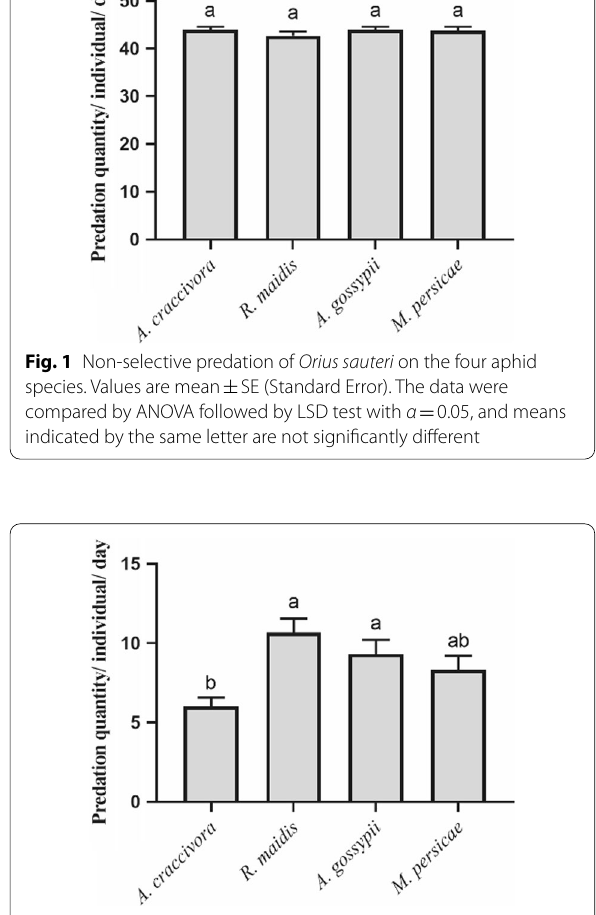
Fig. 2 Selective predation of Orius sauteri on the four aphid species. Values are mean SE. The data were compared by ANOVA followed ± by LSD test with α 0.05, and means indicated by the same letter are = not significantly